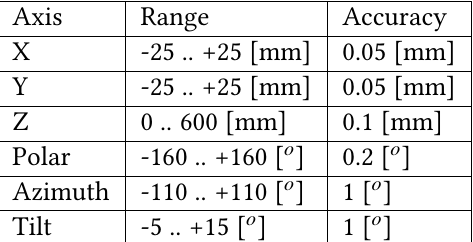
Table 1: Ranges and accuracies of sample manipulator axes of “Cryoax